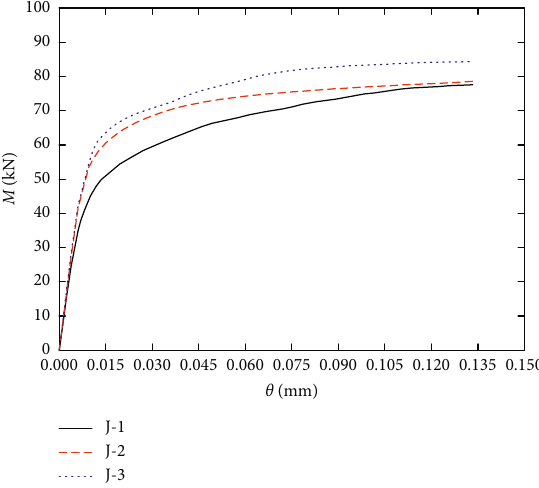
Figure 10: Comparison of the moment-rotation